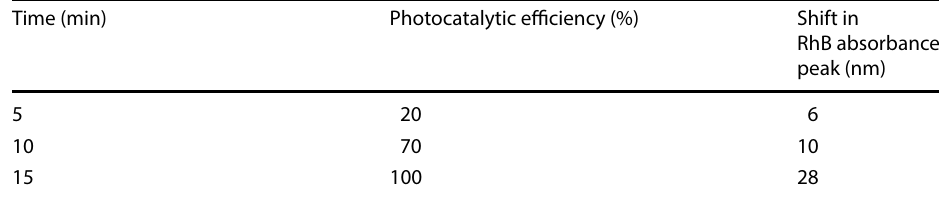
Table 4 Time dependence study of ZnO